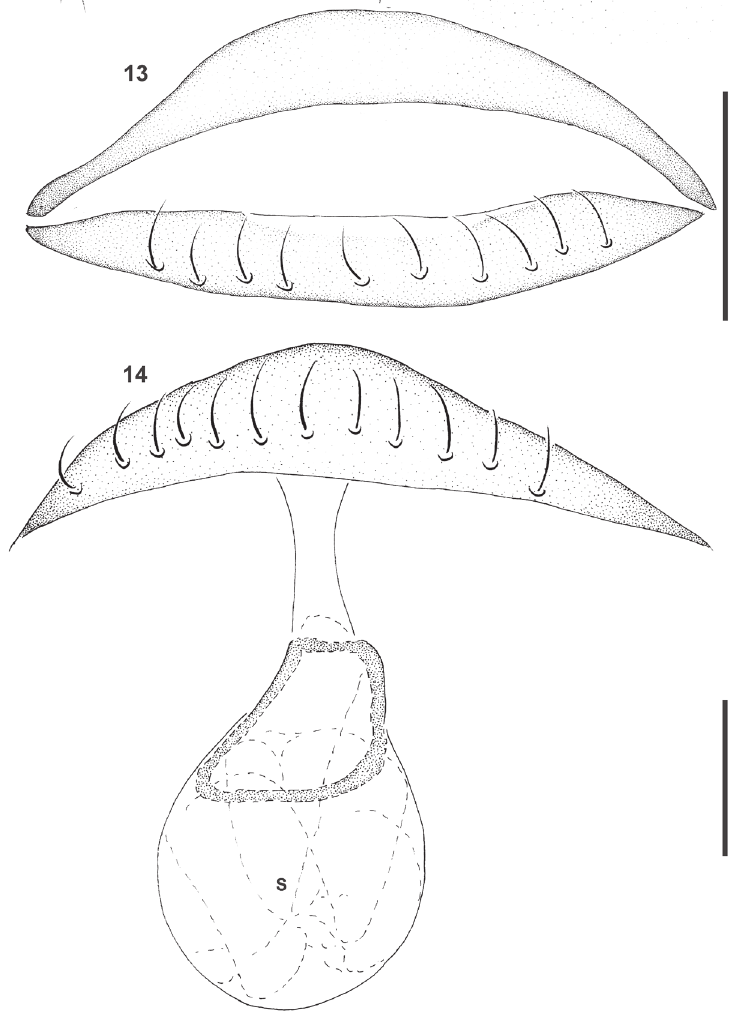
Figures 13–14. Cangoderces globosa sp. n., female holotype. 13 genital area, ventral view 14 genitalia, dorsal view. Abbreviation: S – spermatheca. Scale bars: 0.10 mm. Total length 1.32. Prosoma 0.63 long, 0.55 wide. Opisthosoma 0.66 long, 0.63 wide. Carapace, sternum saffron yellow (Fig. 1). Legs, labium, endites and chelicerae yellow. Six eyes, anterior row of four eyes slightly recurved; AME close together, nearly touching, separated from ALE by 1/4 of ALE diameter; lateral eyes contiguous. Cheli- cerae (Fig. 8) longer than endites, with seven tiny granulate denticles on promargin, six small triangular teeth on retromargin. Leg patellae I–IV with one long spine distally, tibiae I–IV with one long spine medially. Leg measurements: I 3.95 (1.25, 0.19, 1.12, 0.81, 0.58); II 3.42 (1.12, 0.17, 1.00, 0.63, 0.50); III 2.40 (0.80, 0.16, 0.62,